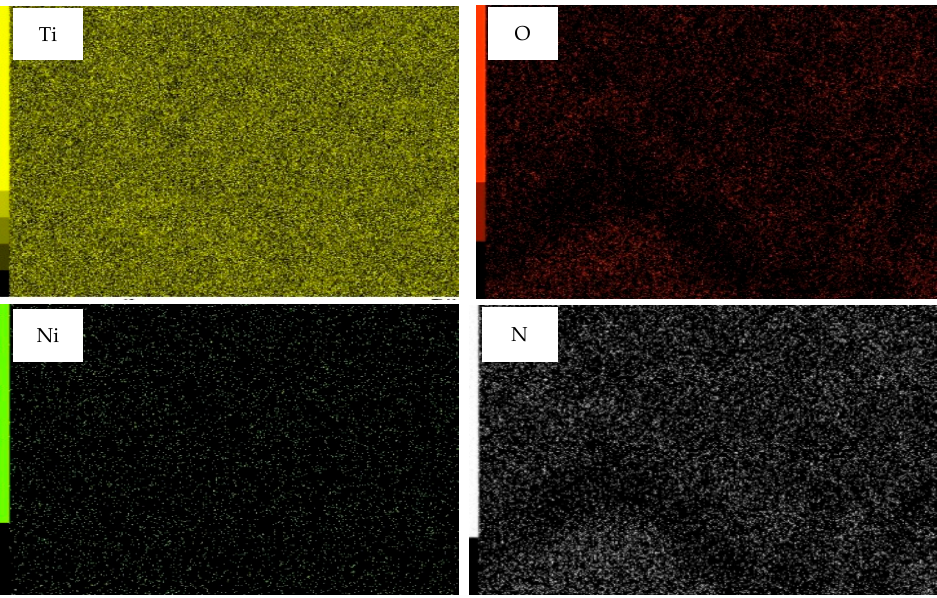
Figure 3. Elemental mapping of Ni-N-TiNTAs .